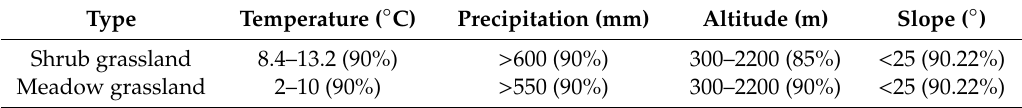
Table 2. Habitat characteristics of shrub grassland and meadow grassland